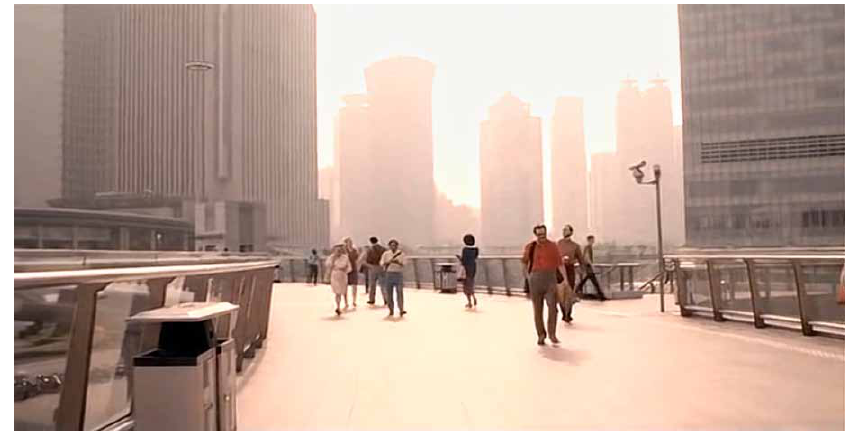
fig. 18. Her : Shanghai’s lujiazi pedestrian bridge